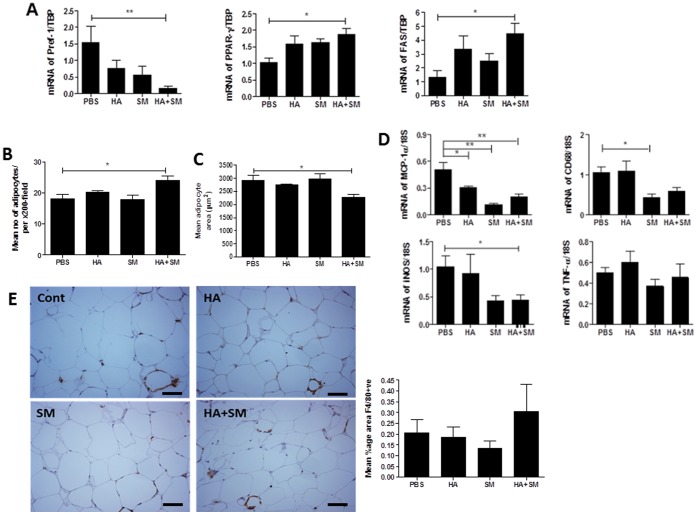
HA+SM promotes adipogenesis and reduces inflammatory gene expression in db/db mice.
A. Relative expression of Pref-1, PPARγ, FASN genes and B. Mean adipocyte number per 200x magnification, C. Mean adipocyte area in the epididymal fat pads of each treatment group. D. Relative expression of MCP-1α, CD68, iNOS, TNF-α genes, E. Representative figures (200x) and quantification for F4/80 staining in adipose tissue. Scale bars represent 25 µM *P<0.05, **P<0.01. P-values derived from Bonferroni’s multiple comparison post-test where P<0.05 by one-way analysis of variance. The data are means ± s.e.m from n = 4–8/group.